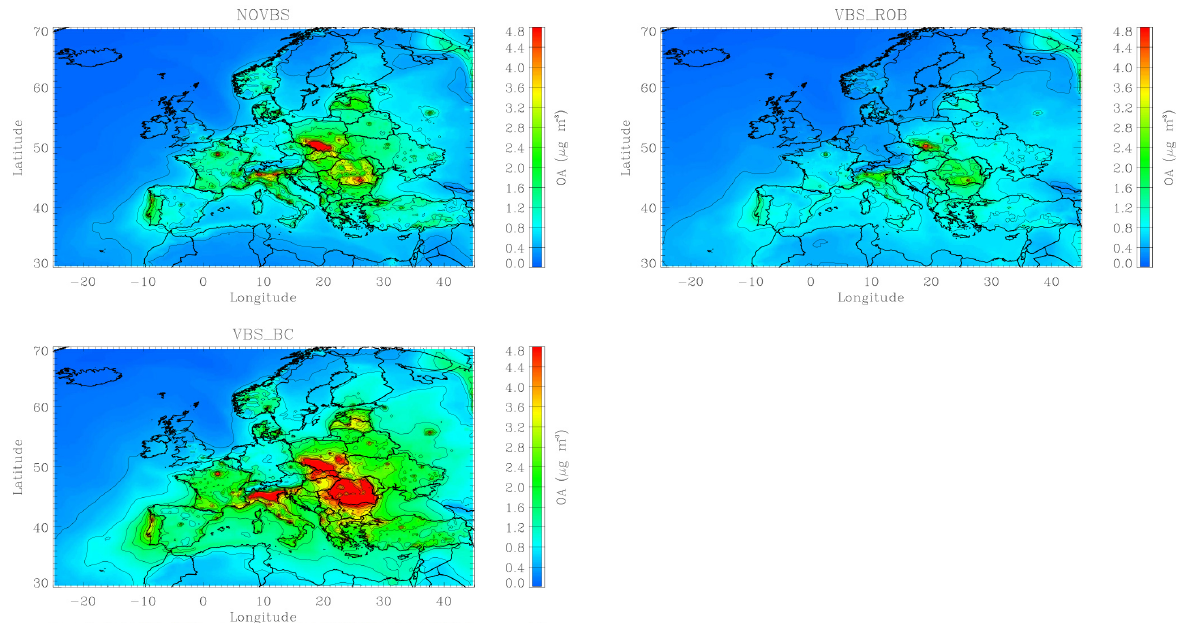
Figure 6. Predicted OA concentrations over Europe for the NOVBS, VBS_ROB and VBS_BC scenario in February–March 2009. Note that the colour scale was limited to a maximum of 4.8µgm − 3 to facilitate comparison of the panels.